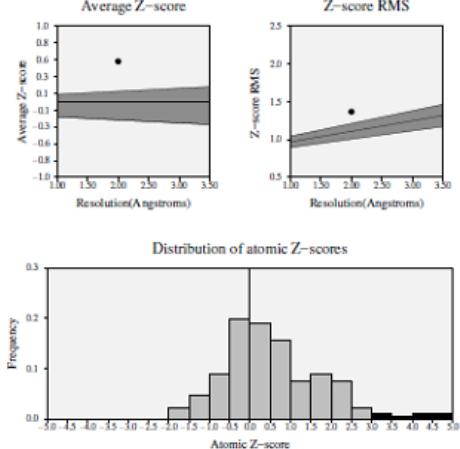
Figure 3. Z-score value calculated via PROVE software. Z-score mean: 0.535, Z-score SD: 1.261, Z-Score RMS: 1.368, Outliers: